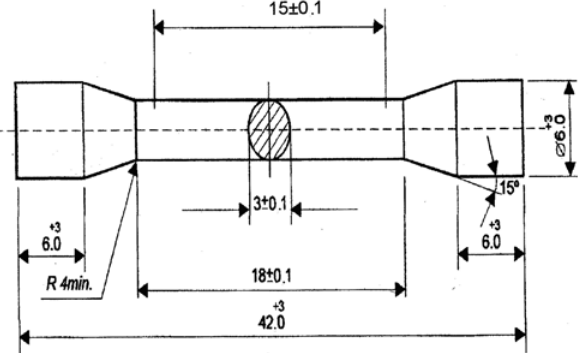
FIGURE 1- represents illustrative of the specimen for the traction test and the respective dimensions